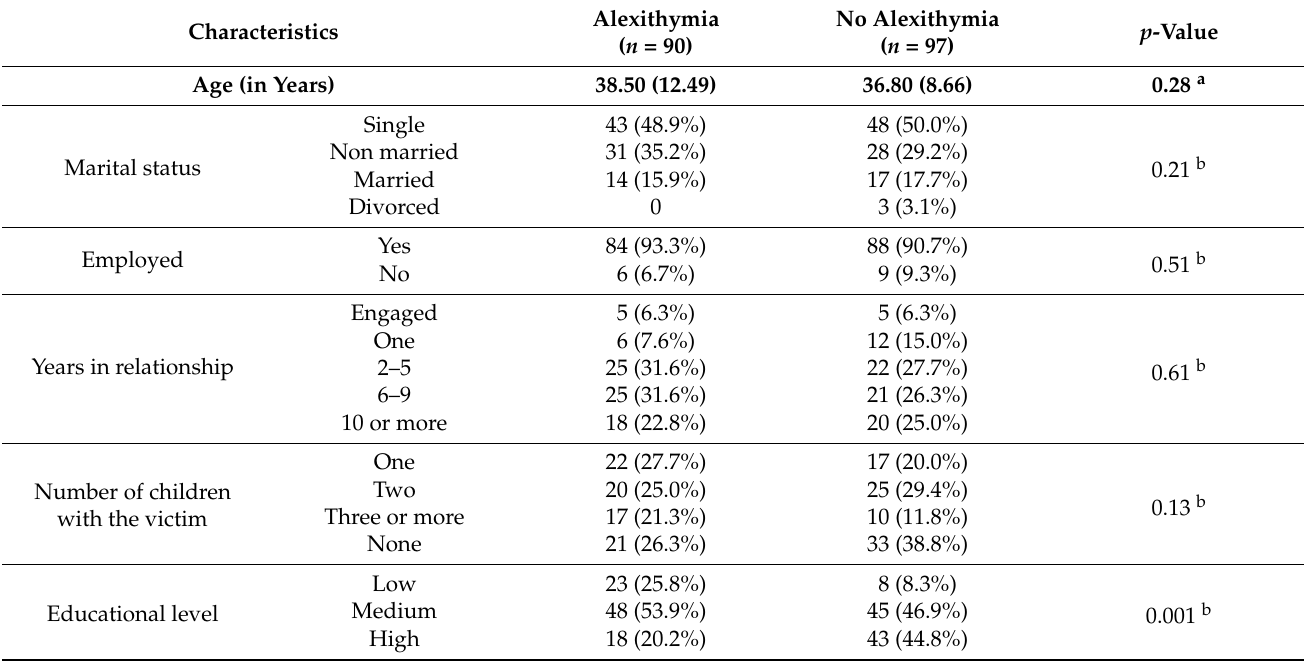
Table 1. Comparison of socio-demographic data between the alexithymia and no alexithymia groups.